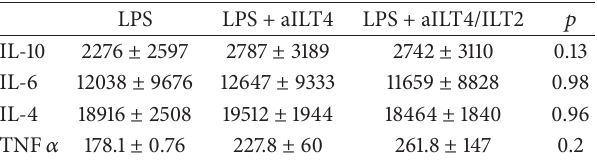
Table 2: Effect of activation of ILT4 and/or ILT2 on cytokine release by DC from healthy controls.